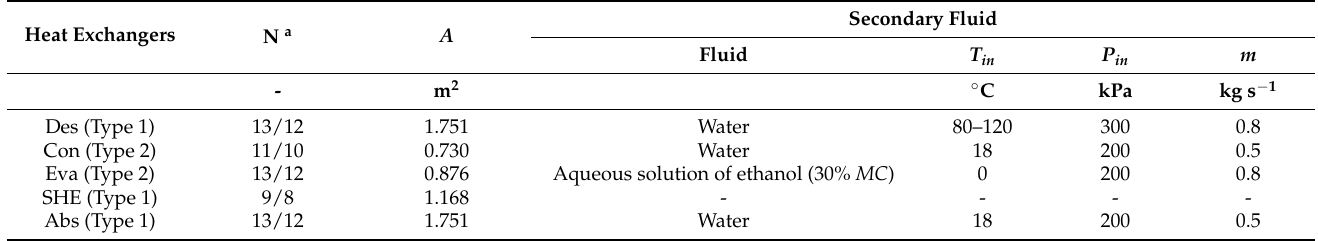
Table 4. Input parameters of the heat exchangers and secondary fluids for sub-zero